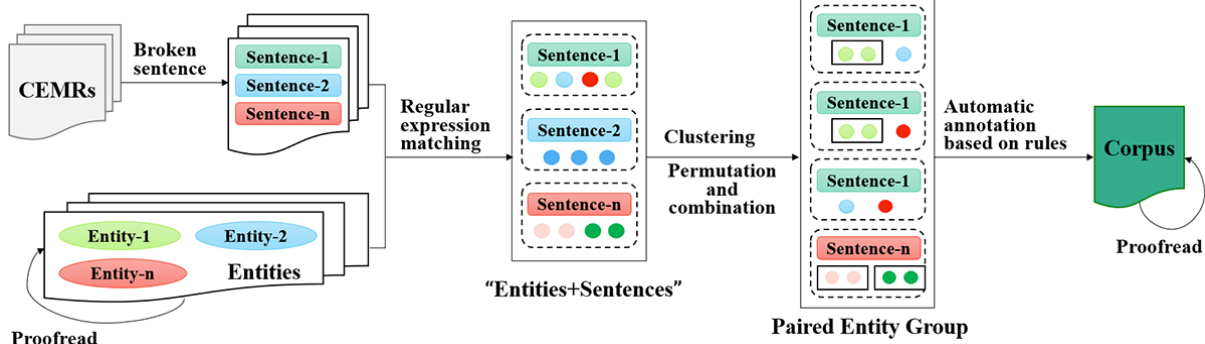
Figure 5. Construction process of the relational extraction corpus. CEMR: Chinese electronic medical